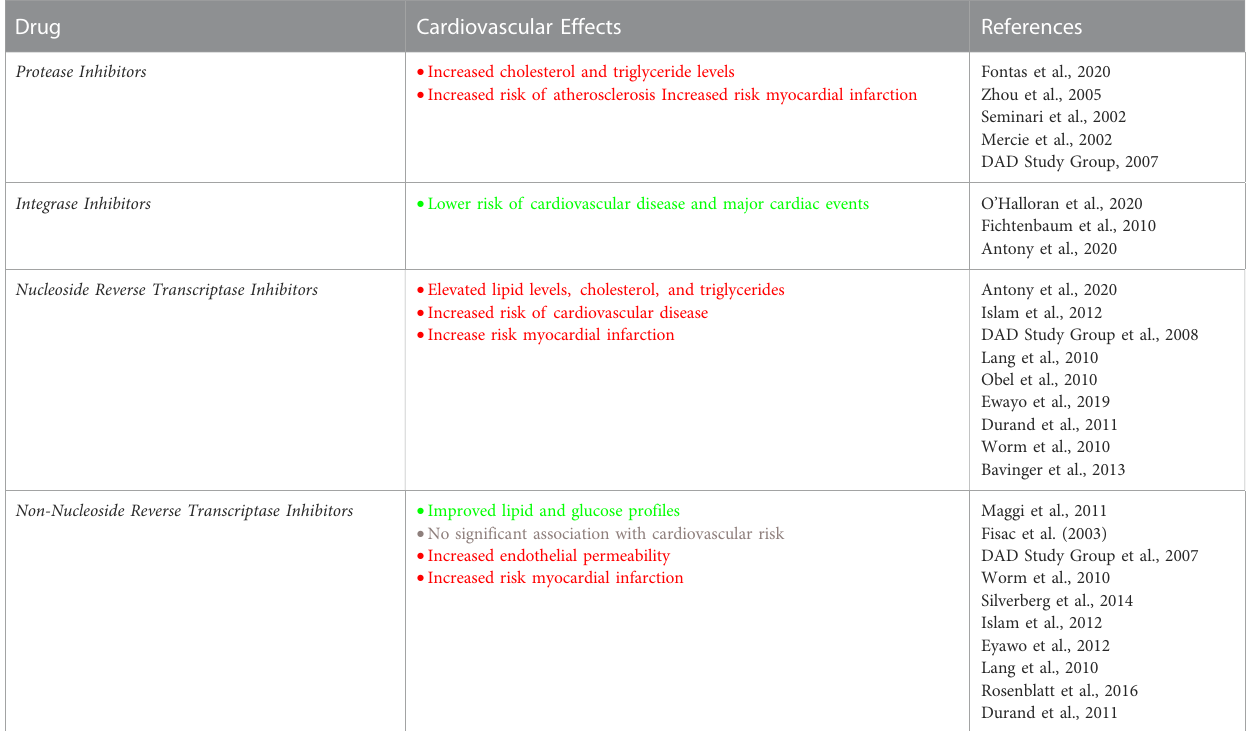
TABLE 1 Individual Drug Classes and Cardiovascular Health Risk. Drug Cardiovascular Effects